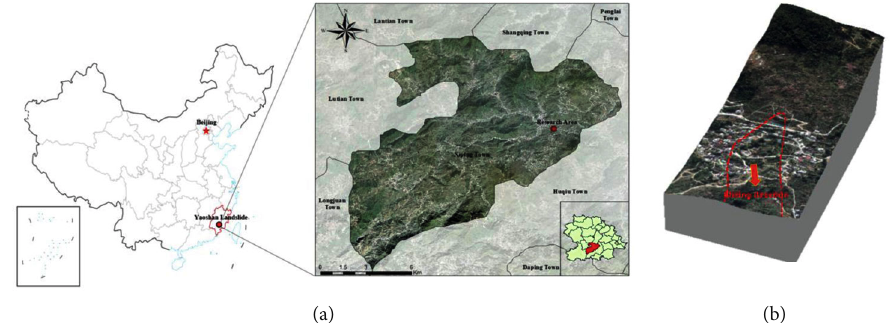
Figure 2: Location map and three-dimensional topographic map of the study area. (a) Location map. (b) Three-dimensional topographic map.